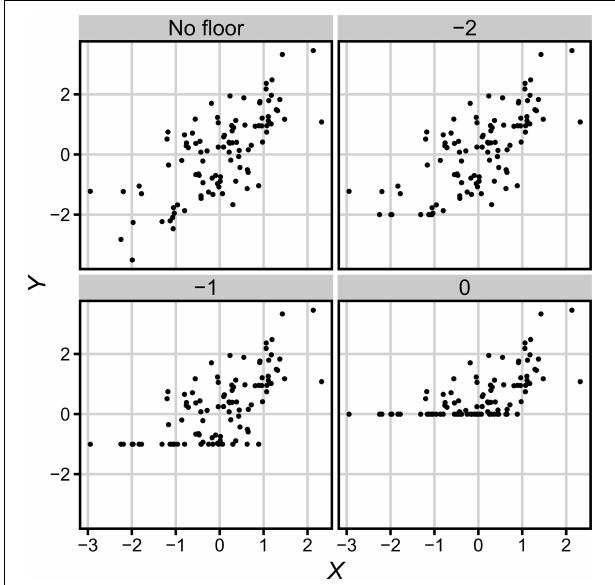
FIGURE 2 | Observed data Y for different values of floor f . See description in